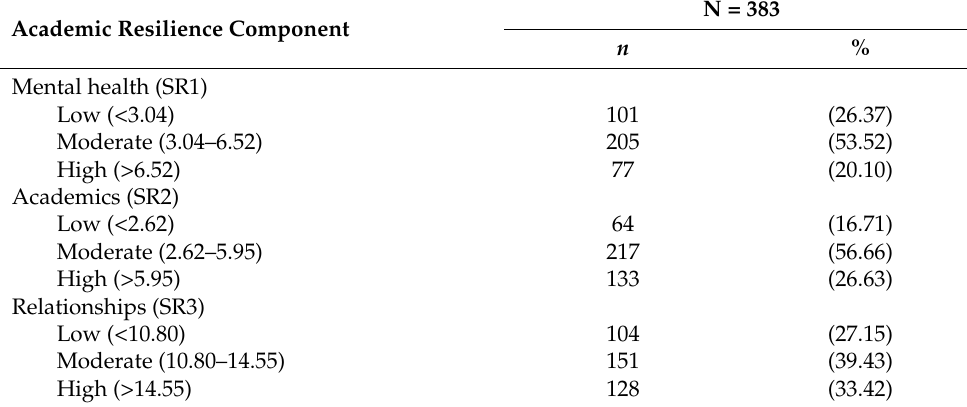
Table 5. Perception of academic resilience among respondents (N =